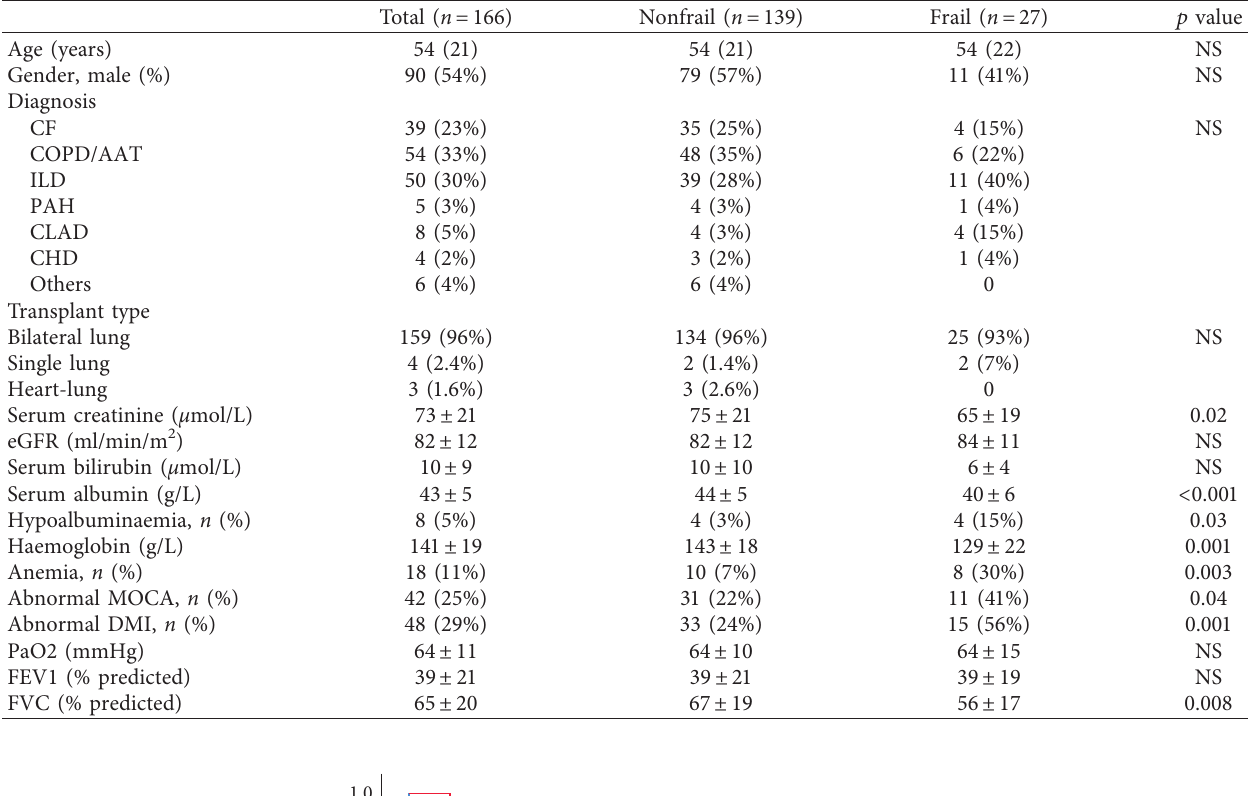
Table 2: Comparison of demographics and baseline prognostic markers of a study population stratified by physical frailty status. Total ( n � 166)